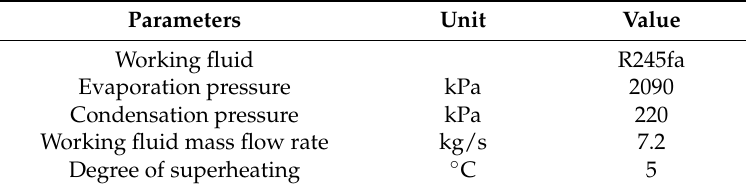
Table 5. Design point operating conditions of 200-kW ORC system.